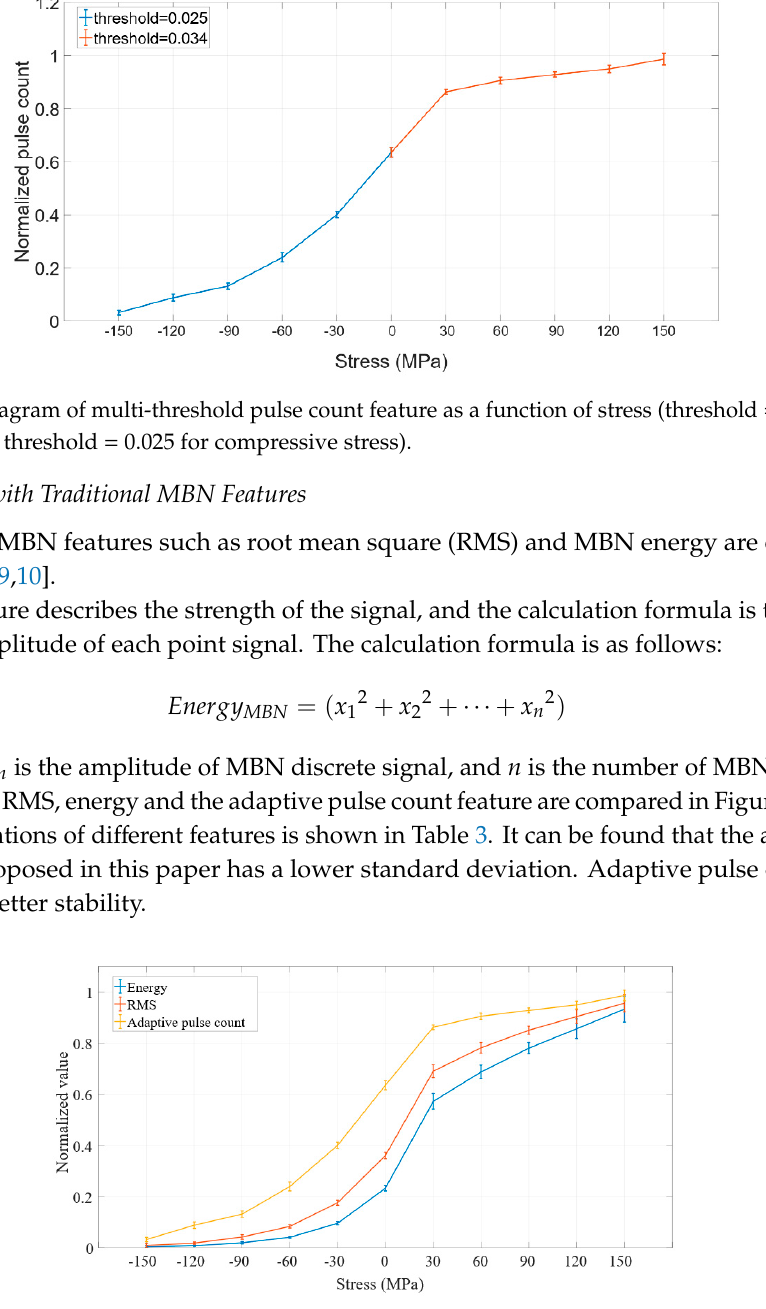
Figure 13. The figure compares normalized root mean square (RMS), energy and the adaptive pulse count feature under different stress conditions. Table 3. The sum of standard deviation and sum of ‘overlap’ of different features. Feature Sum of Standard